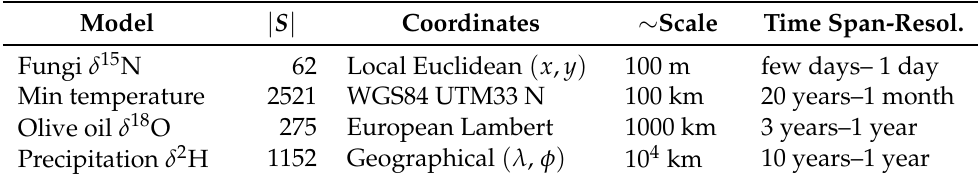
Table 2. Model features. | S | is the number of source events.